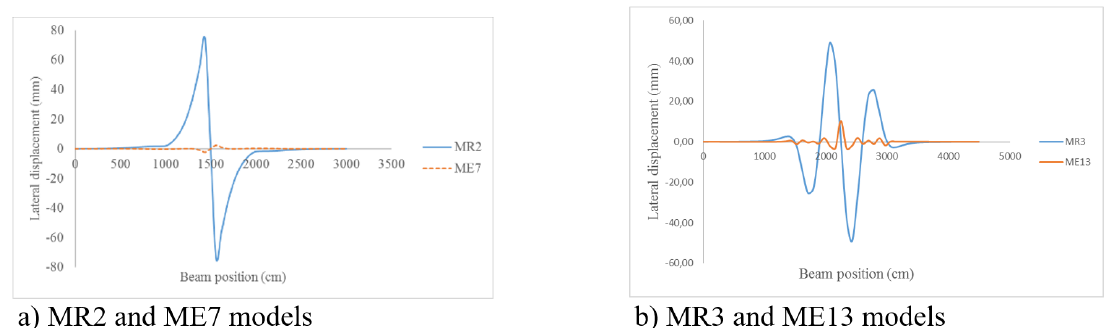
Figure 13. Lateral displacement of the bottom flange of the steel